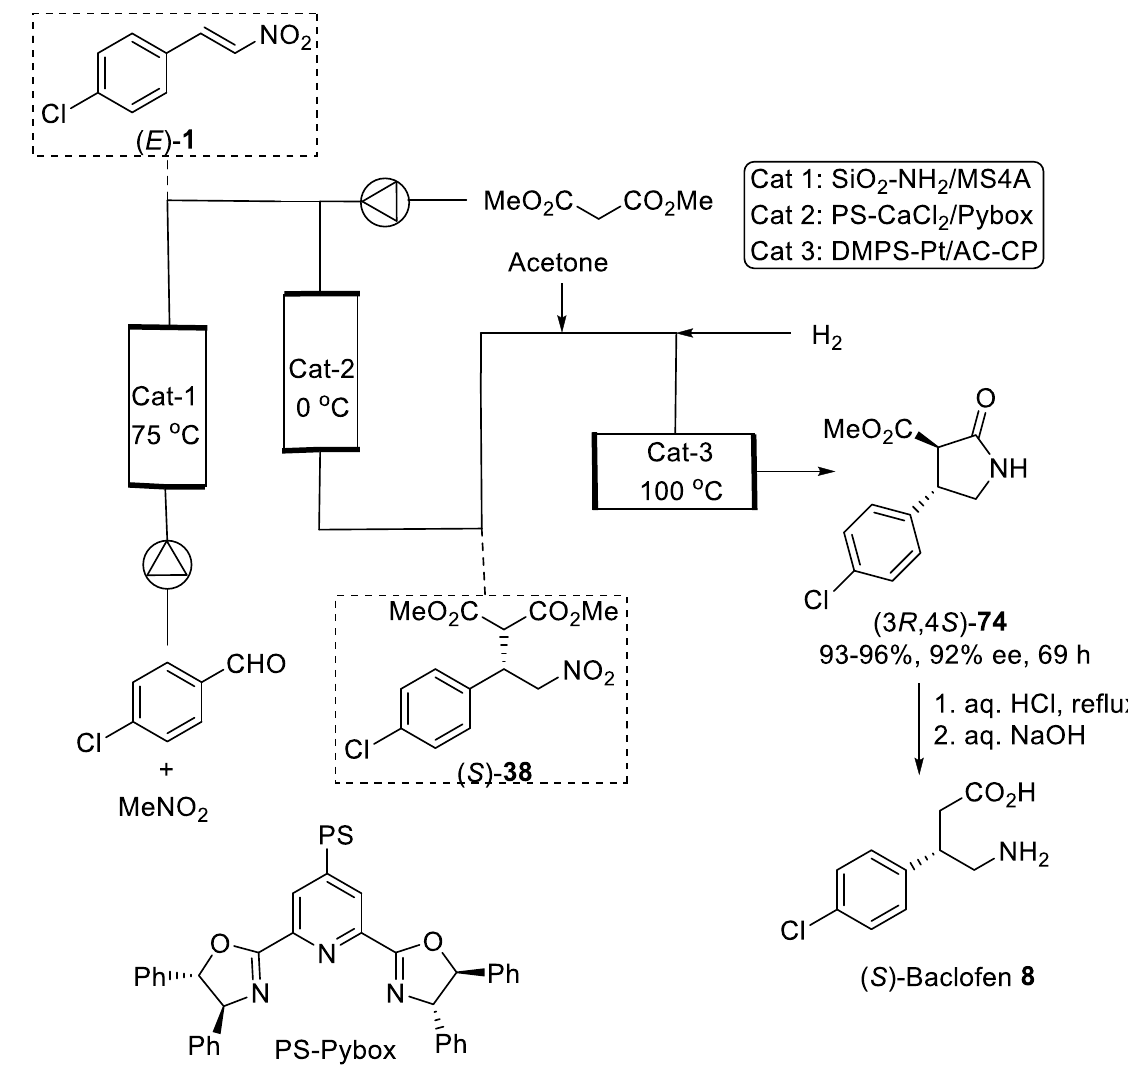
Figure 2. Sequential flow synthesis of Baclofen precursor (3 R ,4 S )- 74 .